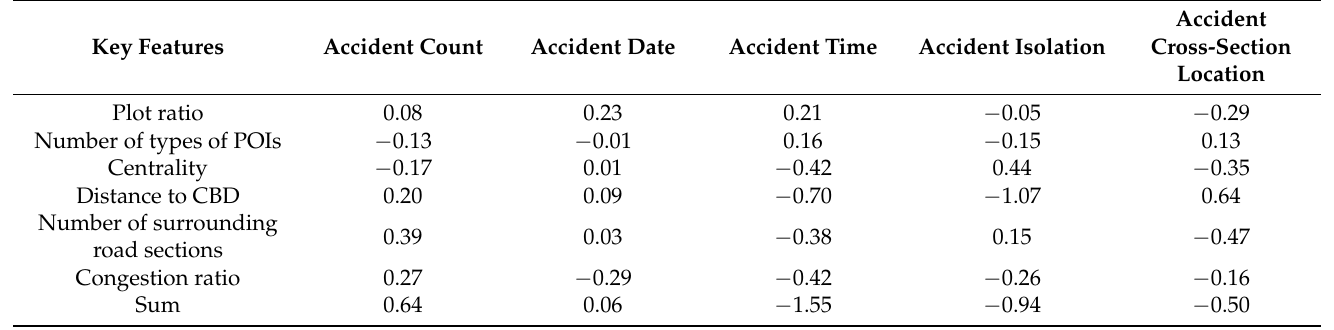
Table 9. W o after